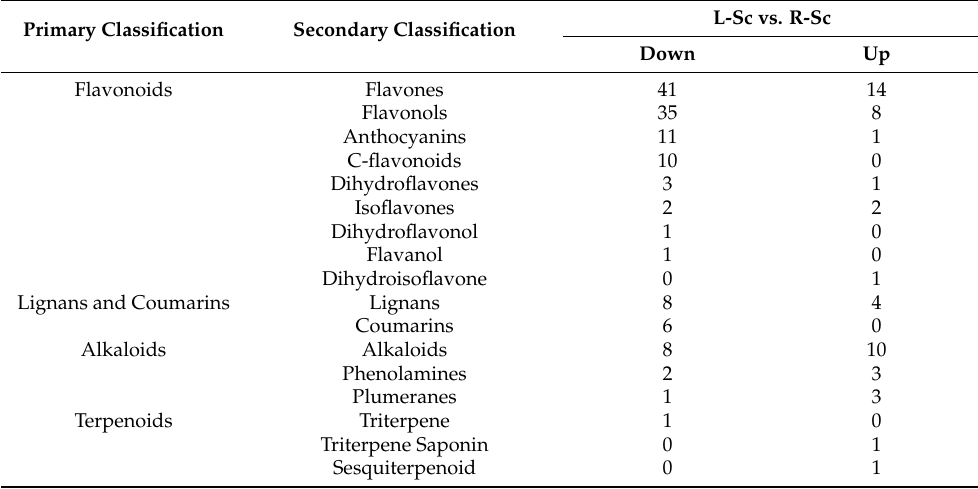
Table 2. Overview of the differentially accumulated metabolites in potential antioxidant components between L-Sc and